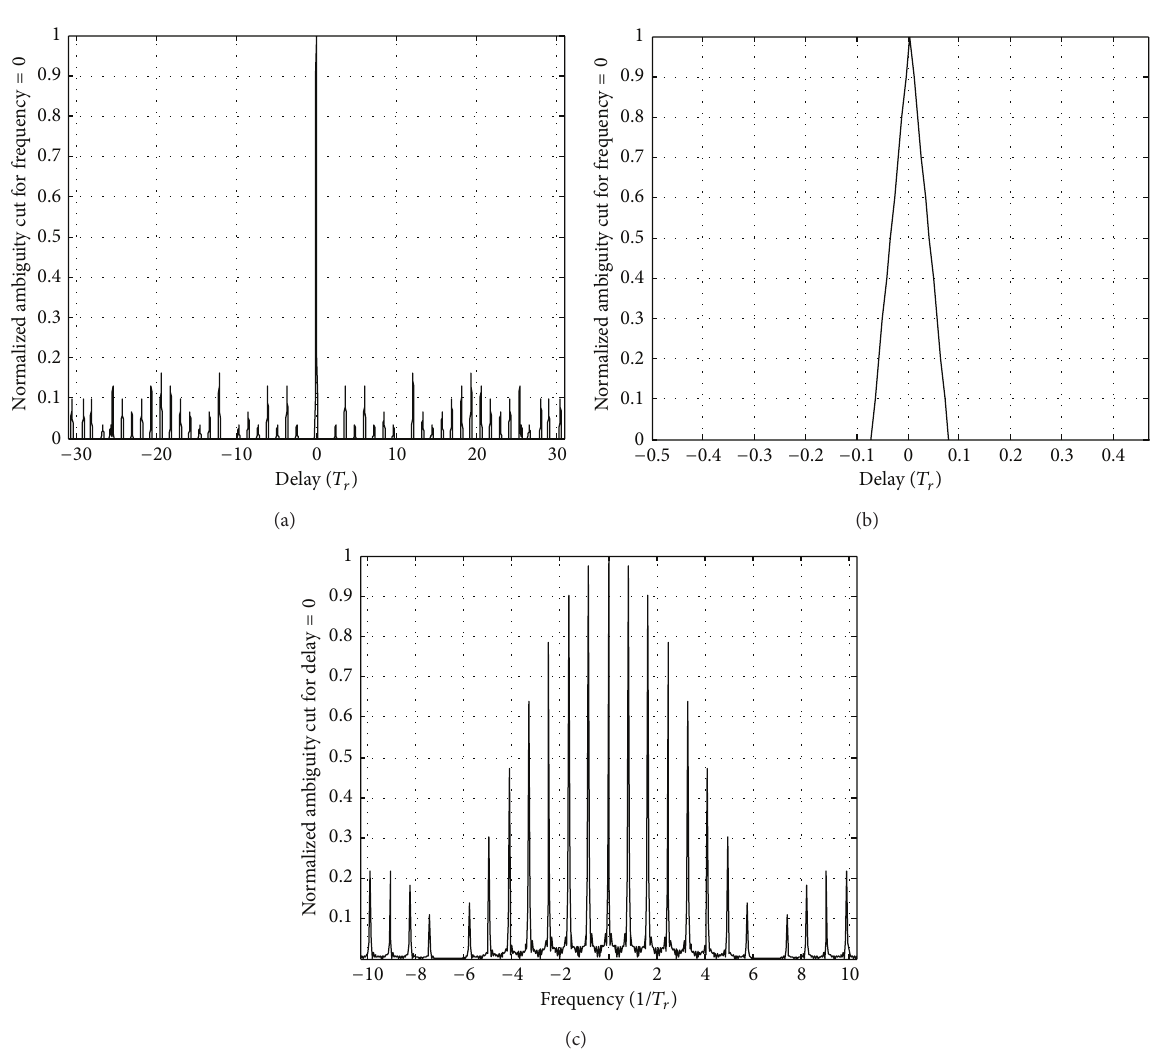
Figure 11: The ranging and velocity ambiguity function for 𝑁 𝑝 = 31 and 𝑇 𝑟 = 7𝑡 𝑝 .